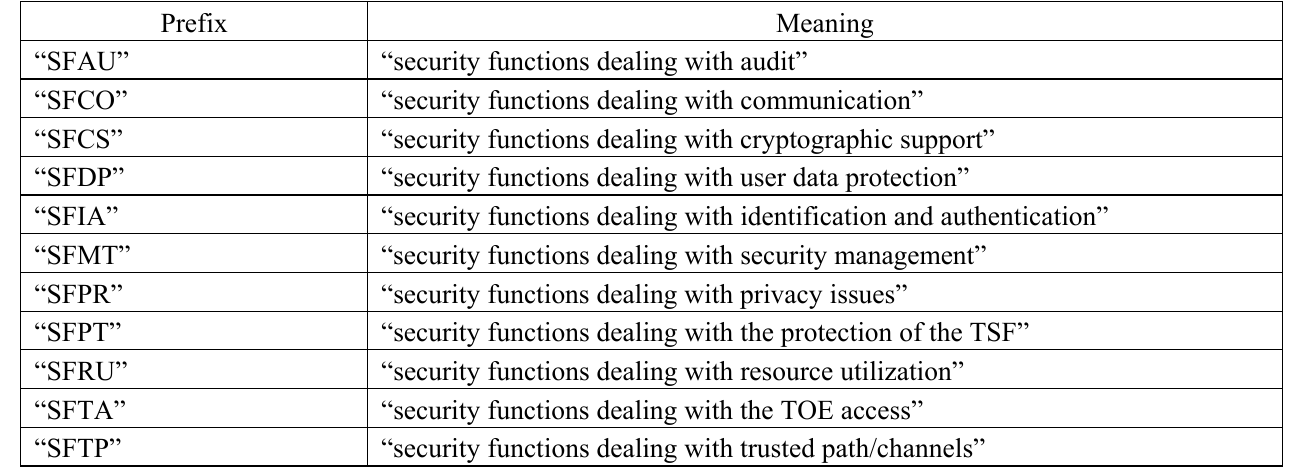
Table 7. Family field related to the security